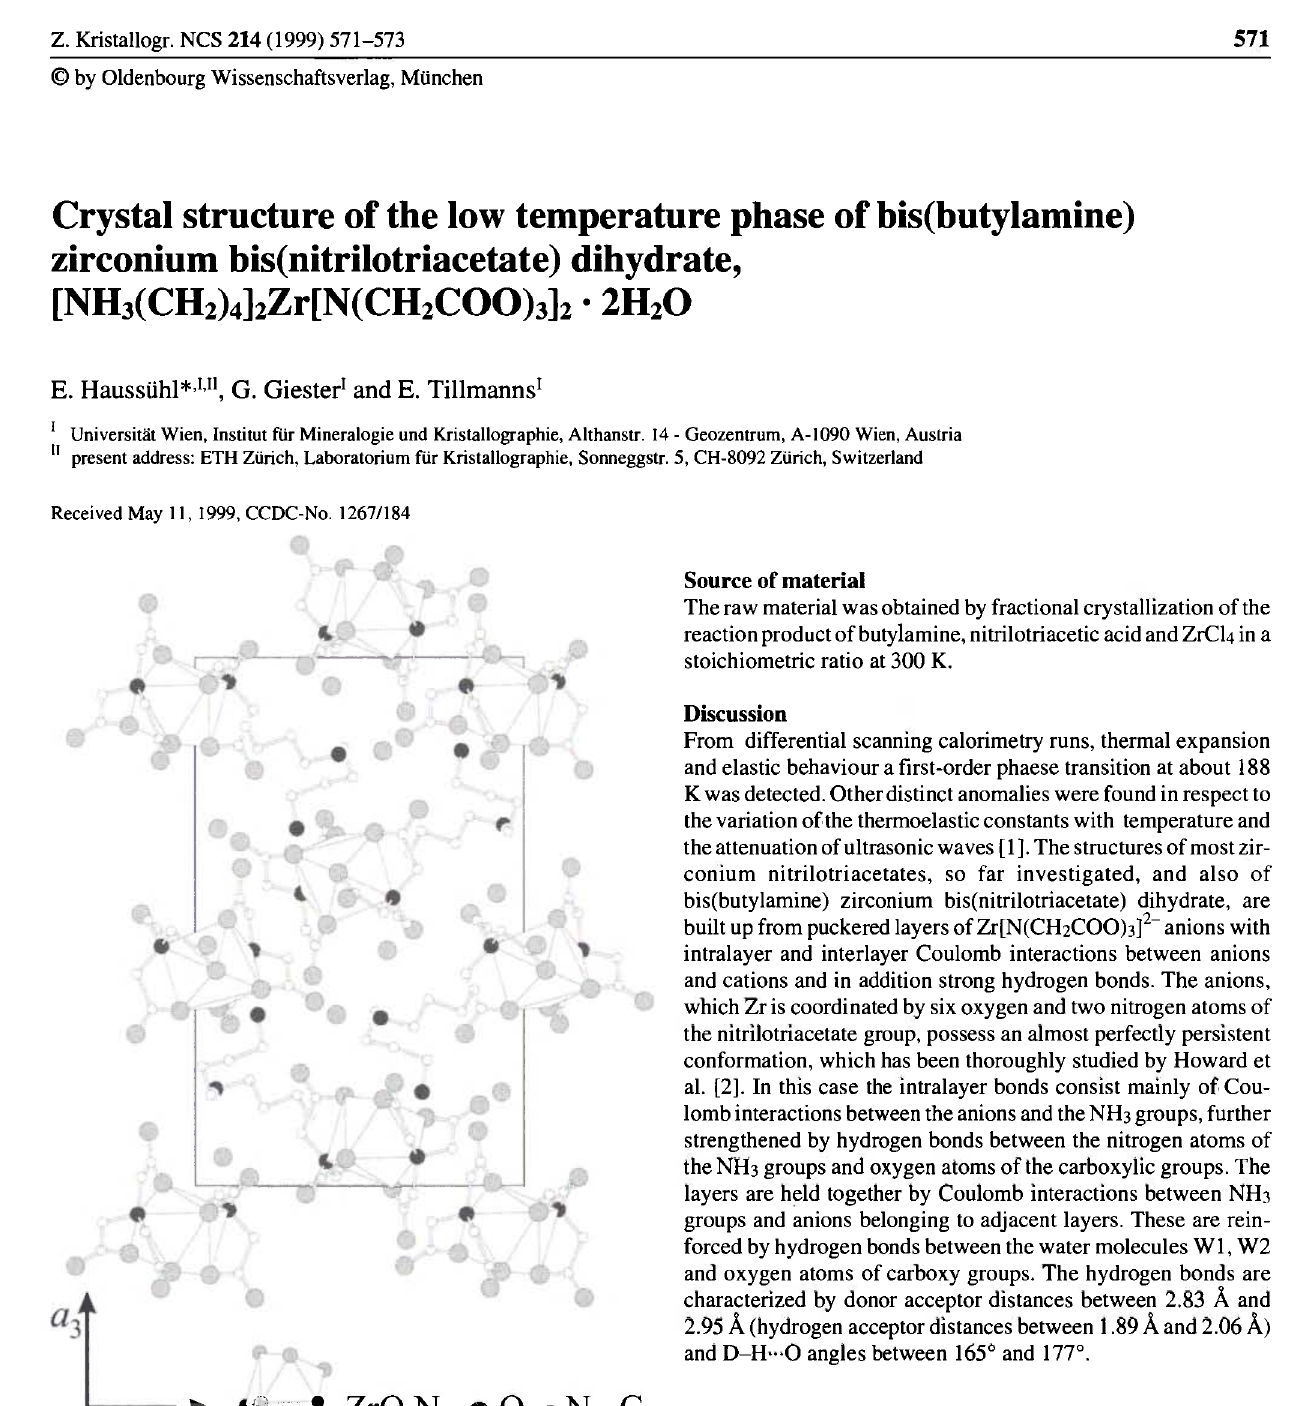
Table 1. Data collection and handling.